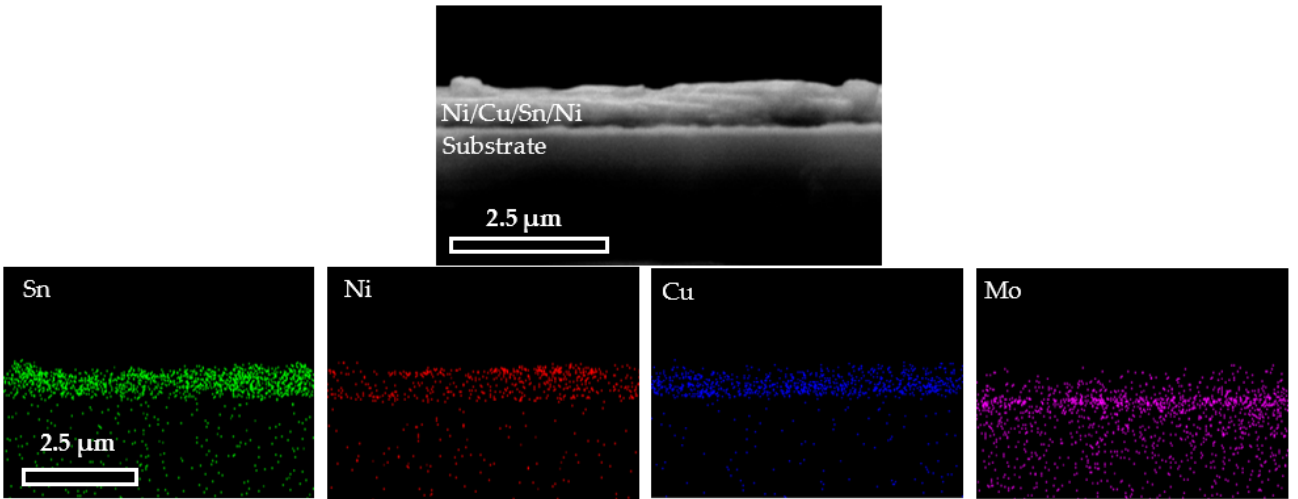
Figure 1. The SEM and EDX mapping images of the cross-section of the Ni/Cu/Sn/Ni precursors on a glass/Mo substrate.